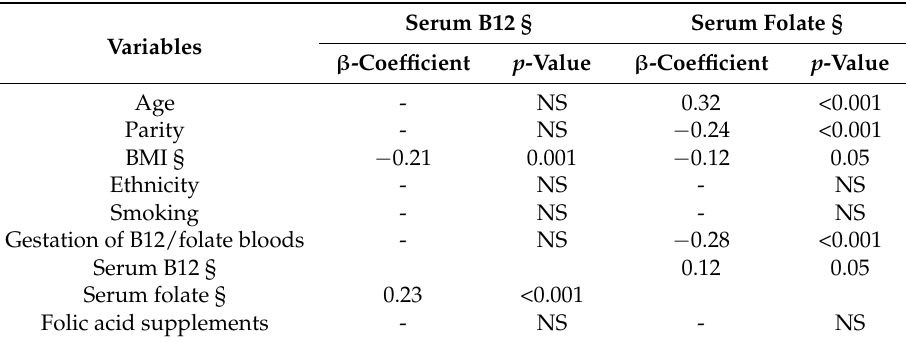
Table 2. Predictors of vitamin B12 and folate.